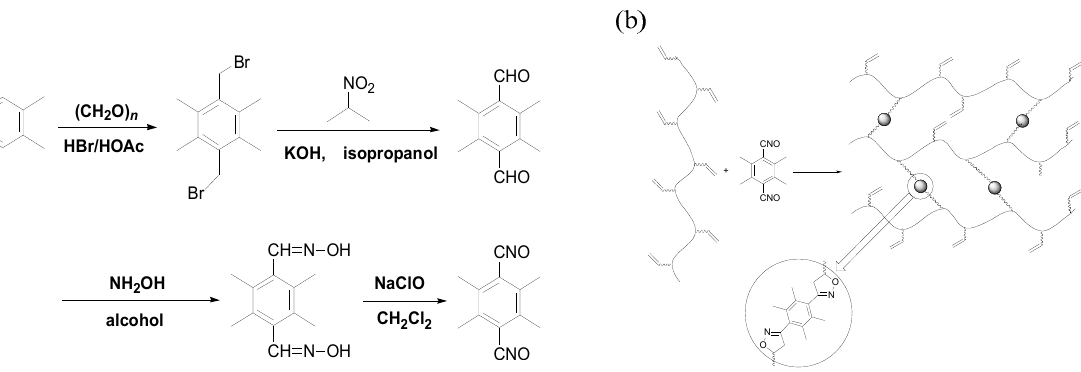
Figure 1. Synthesis of rubber material: ( a ) synthesis of TTNO and ( b ) formation of the cross-linked rubber material.